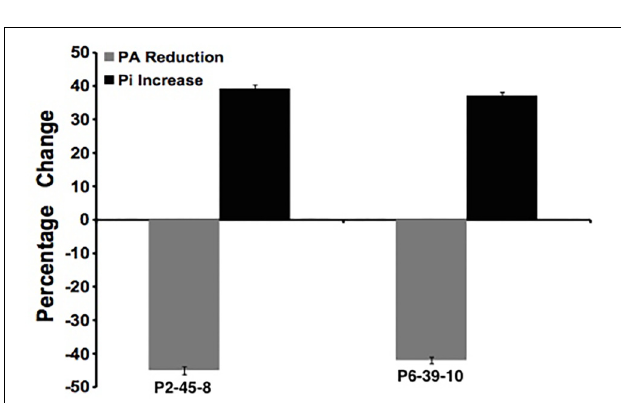
FIGURE 9 | Percentage reduction in phytate (gray column) and increase in free phosphate (black column) in P2-45-8 and P6-39-10 transgenic lines.